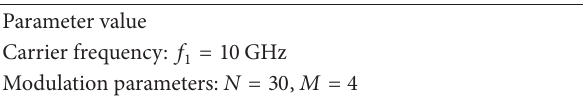
Table 2: Simulation